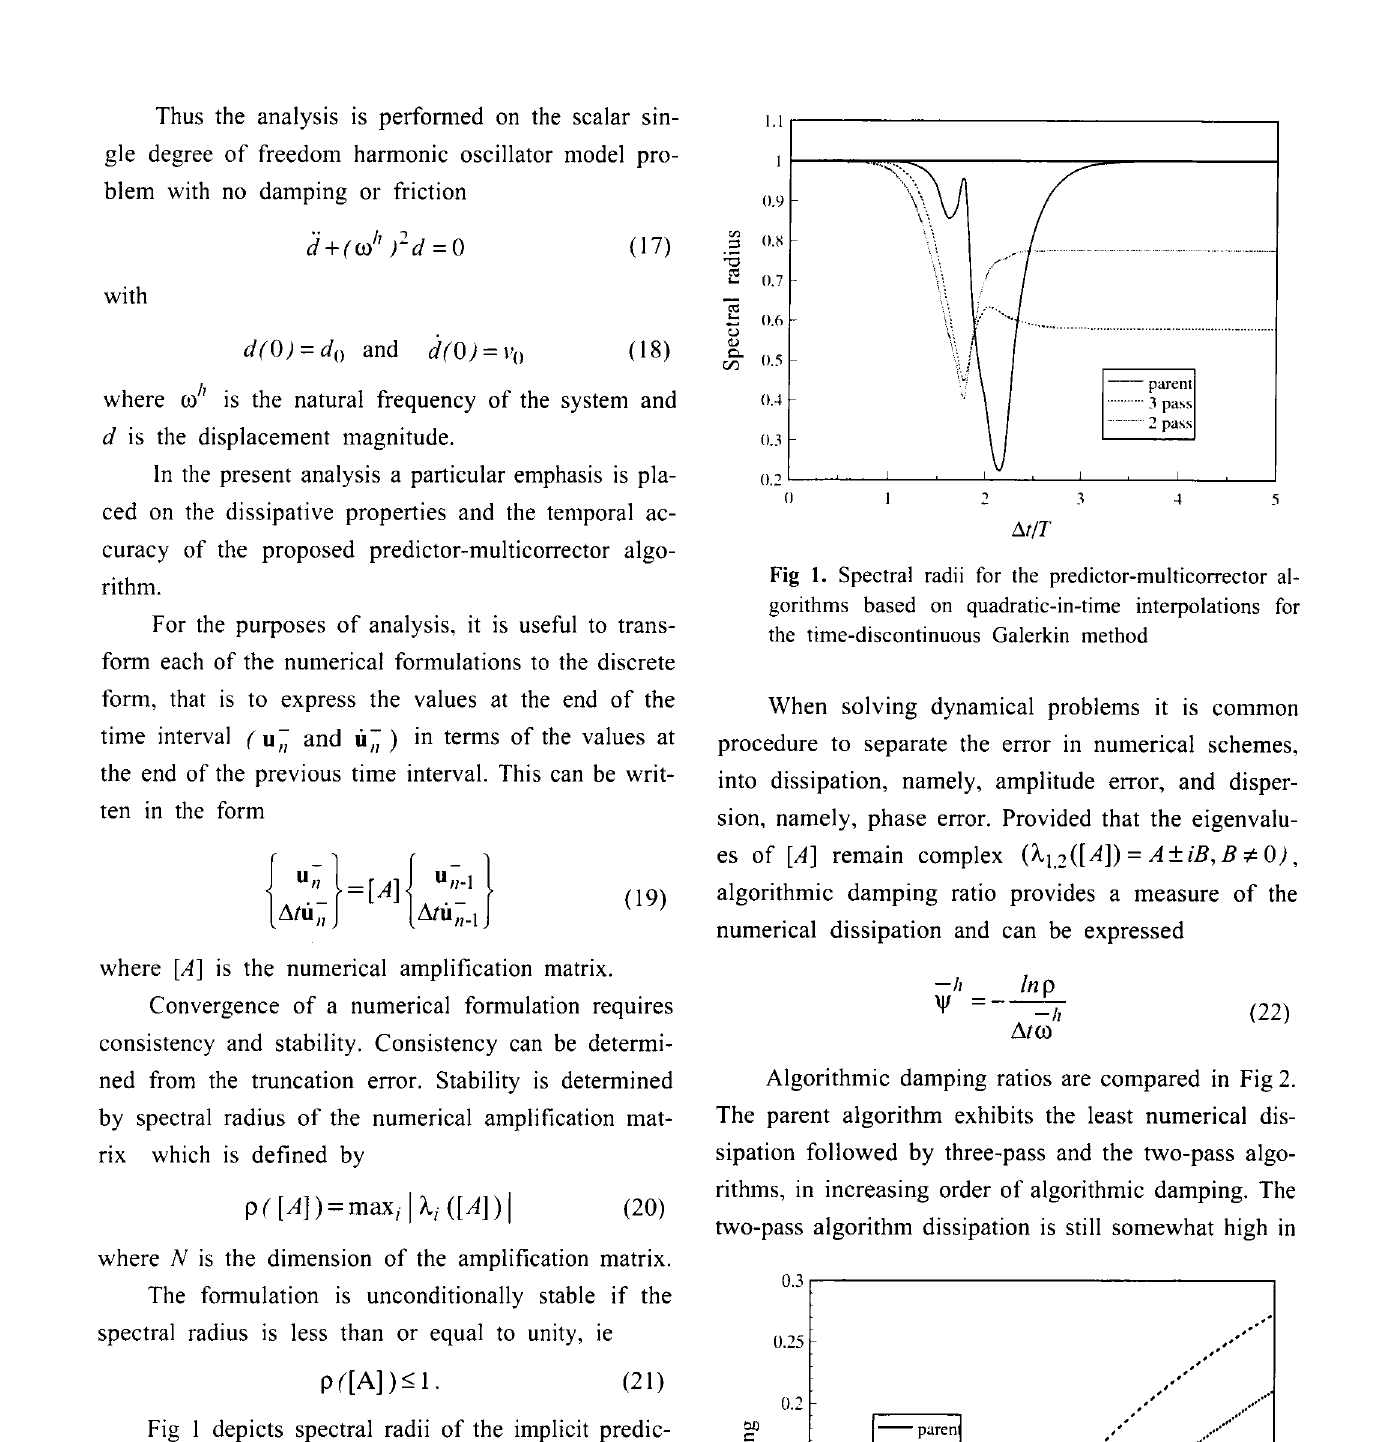
Fig 2. Algorithmic damping ratios for the predictor multicorrector algorithms based on quadratic-in-time in terpolations for the time-discontinuous Galerkin method